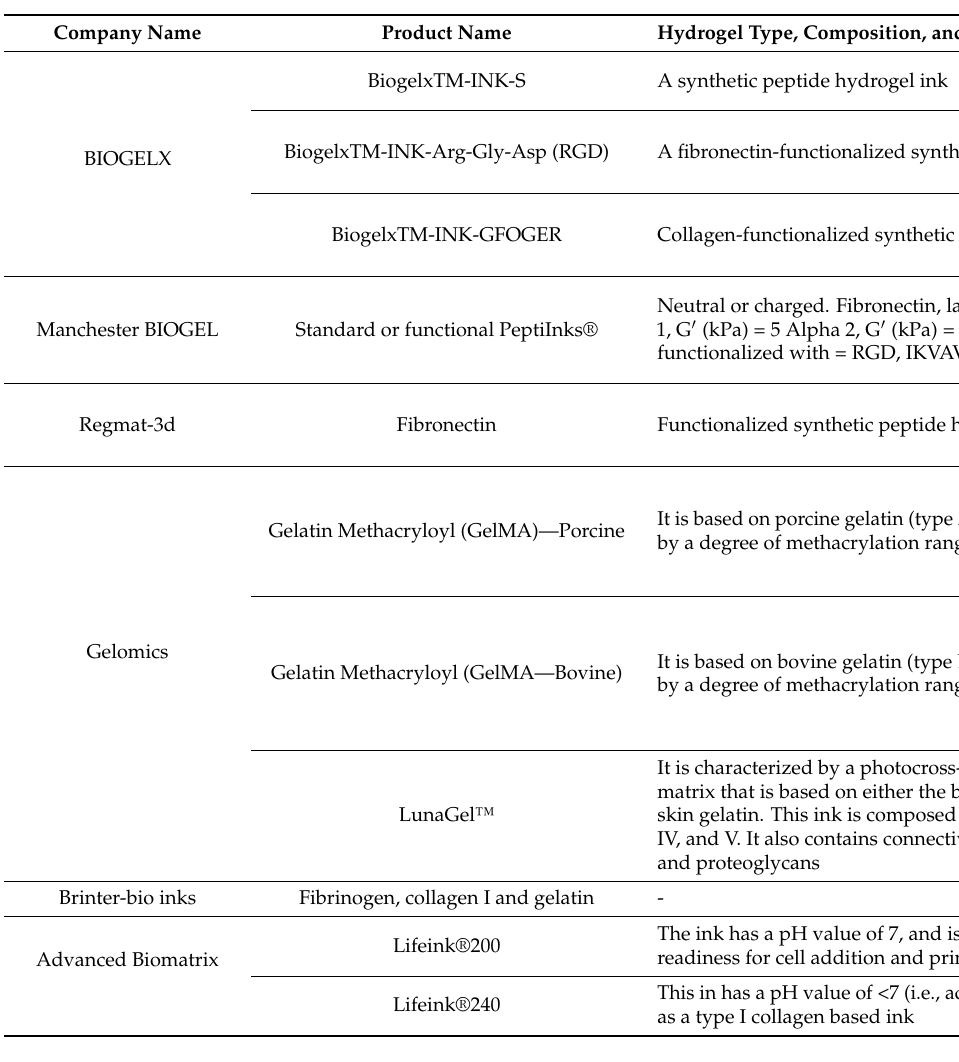
Table 5. Commercially available 3D printable protein/polypeptide-based hydrogels